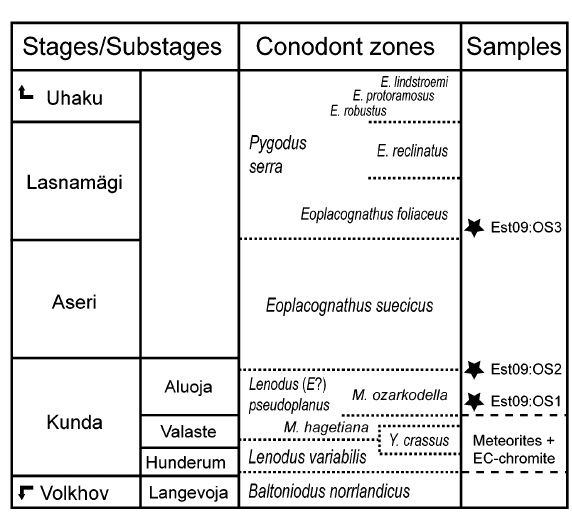
Fig. 7. Chrono- and biostratigraphical chart (trimmed and modified from Fig. 2), showing the approximate stratigraphical positions of the investigated samples, as well as the interval of particularly high abundances of extraterrestrial material (meteorites and sediment-dispersed L-type chondritic grains; after Schmitz et al. 2008). Abbreviations as in Fig.